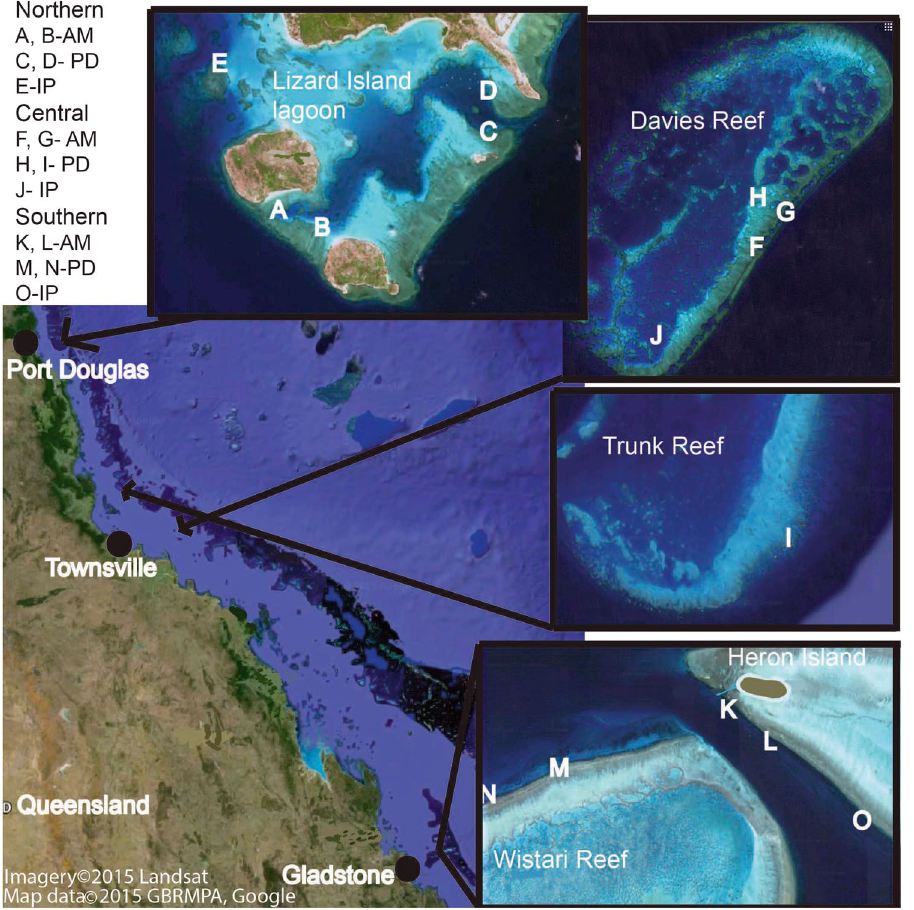
Figure 1. Map of study sites along the Great Barrier Reef. Sites A,B ( A . muricata ), C,D ( P . damicornis ), E ( I . palifera ) were in the northern sector at Lizard Island. Sites F, G ( A . muricata ), H, I, ( P . damicornis ), J ( I . palifera ) were in the central sector at Davies and Trunk Reef. Sites K, L, ( A . muricata ), M, N ( P . damicornis ), O ( I . palifera ) were in the southern sector at Heron Island. AM = Acropoca muricata . PD = Pocillopora damicornis . IP = Isopora palifera . Figure data provided by Imagery©2016 Landsat, Data SIO, NOAA, U.S. Navy, NGA, GEBCO, Map data ©2015 GBRMPA, Google